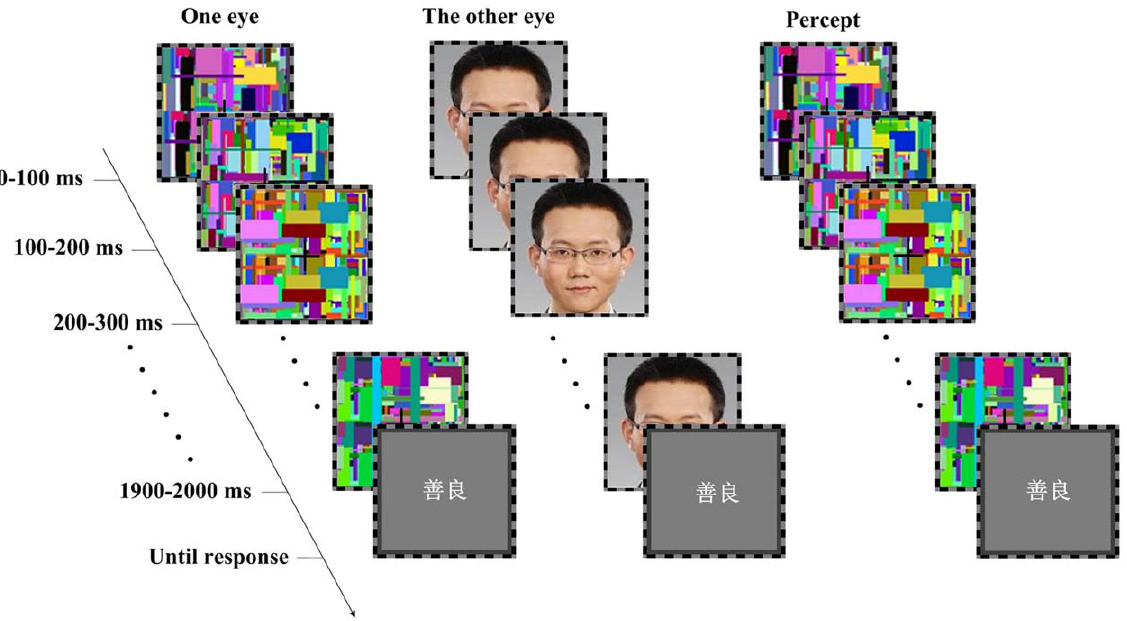
Figure 1. Schematic representation of the experimental paradigm for the main session in Experiment 1. In Experiment 2, the noise patches were replaced by the same face picture presented to the other eye.